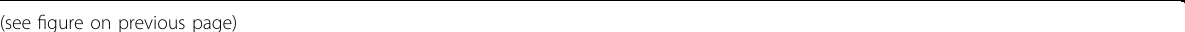
Fig. 4 Ketamine-induced c-fos brain expression in female WT and GluN2CKO mice. c-fos mRNA expression for female ( ♀ ) WT and GluN2CKO mice after saline or ketamine (30 mg/kg) administration. Upper, intermediate, and deep layers of primary and secondary motor cortices (upper M1 – M2, mid M1 – M2, and deep M1 – M2, AP: + 2.10), medial prefrontal cortex (mPFC, AP: + 2.10), cingulate cortex (Cg, AP: + 1.18), caudate-putamen nuclei (CPu, AP: + 1.18), nucleus accumbens (NAc, AP: + 1.18), piriform cortex (Pir, AP: + 1.18), retrosplenial cortex (RSC, AP: − 1.70), hippocampus (HPC, AP: − 1.70), habenula (Hb, AP: − 1.70), paraventricular thalamic nucleus (PV, AP: − 1.70), mediodorsal thalamic nucleus (MD, AP: − 1.70), intermediodorsal thalamic nucleus (IMD, AP: − 1.70), centromedial thalamic nucleus (CM, AP: − 1.70), paracentral thalamic nucleus (PC, AP: − 1.70), ventrolateral thalamic nucleus (VL, AP: − 1.70), reuniens and rhomboid nuclei of the thalamus (Re/Rh, AP: − 1.70), reticular nucleus (RtN, AP: − 1.70), dorsal raphe (DR, AP: − 4.60), crus 1 of the ansiform lobule (Crus1, AP: − 6.00), cerebellar simple lobule (Sim, AP: − 6.00), lobules 4 and 5 of the cerebellar vermis (4/5Cb, AP: − 6.00) and vestibular nucleus (Ve, AP: − 6.00). n = 6 in all groups, except for n = 5 in WT saline groups in RSC, RtN, Crus1, Ve; and n = 4 in WT saline groups in Sim, 4/5Cb; and n = 5 in GluN2CKO saline group in Re/Rh, n = 5 in WT ketamine groups in IMD, CM, Re/Rh, 4/ 5Cb; and n = 5 in GluN2CKO ketamine groups in Cg, IMD; and n = 4 in GluN2CKO ketamine groups in Crus1, Sim, Ve. ** p < 0.01 vs. saline; ## p < 0.01 vs. WT (Newman – Keuls post hoc